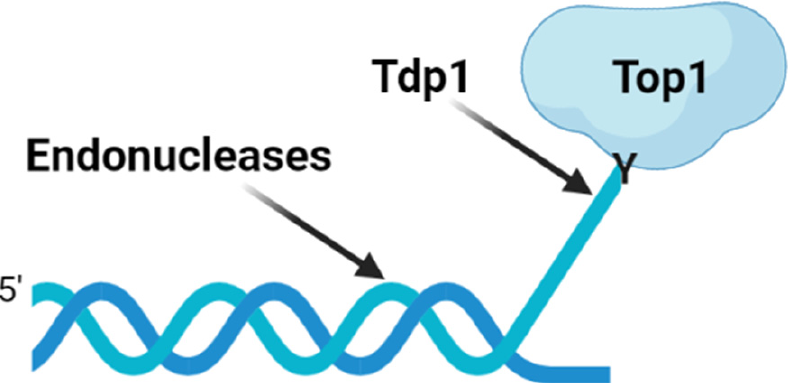
Figure 1. Pathways for the removal of irreversible topoisomerase cleavage complexes. After prote- olysis and/or denaturation of Top1, Tdp1 can hydrolyze the tyrosyl-DNA links. In addition, the endonucleases can remove the DNA segment covalently attached to topoisomerases. Created with Biorender.